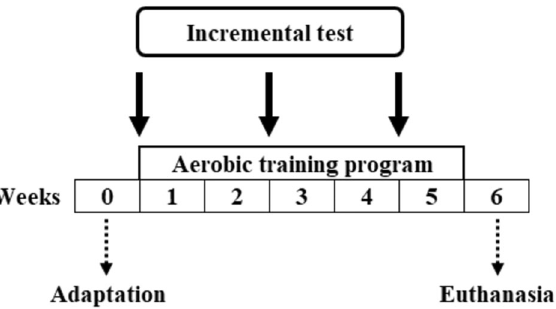
Figure 1. Evaluation schedule that includes adaptation to the treadmill, incremental tests, training programs and euthanasia. ↓ = indicates evaluation moments.